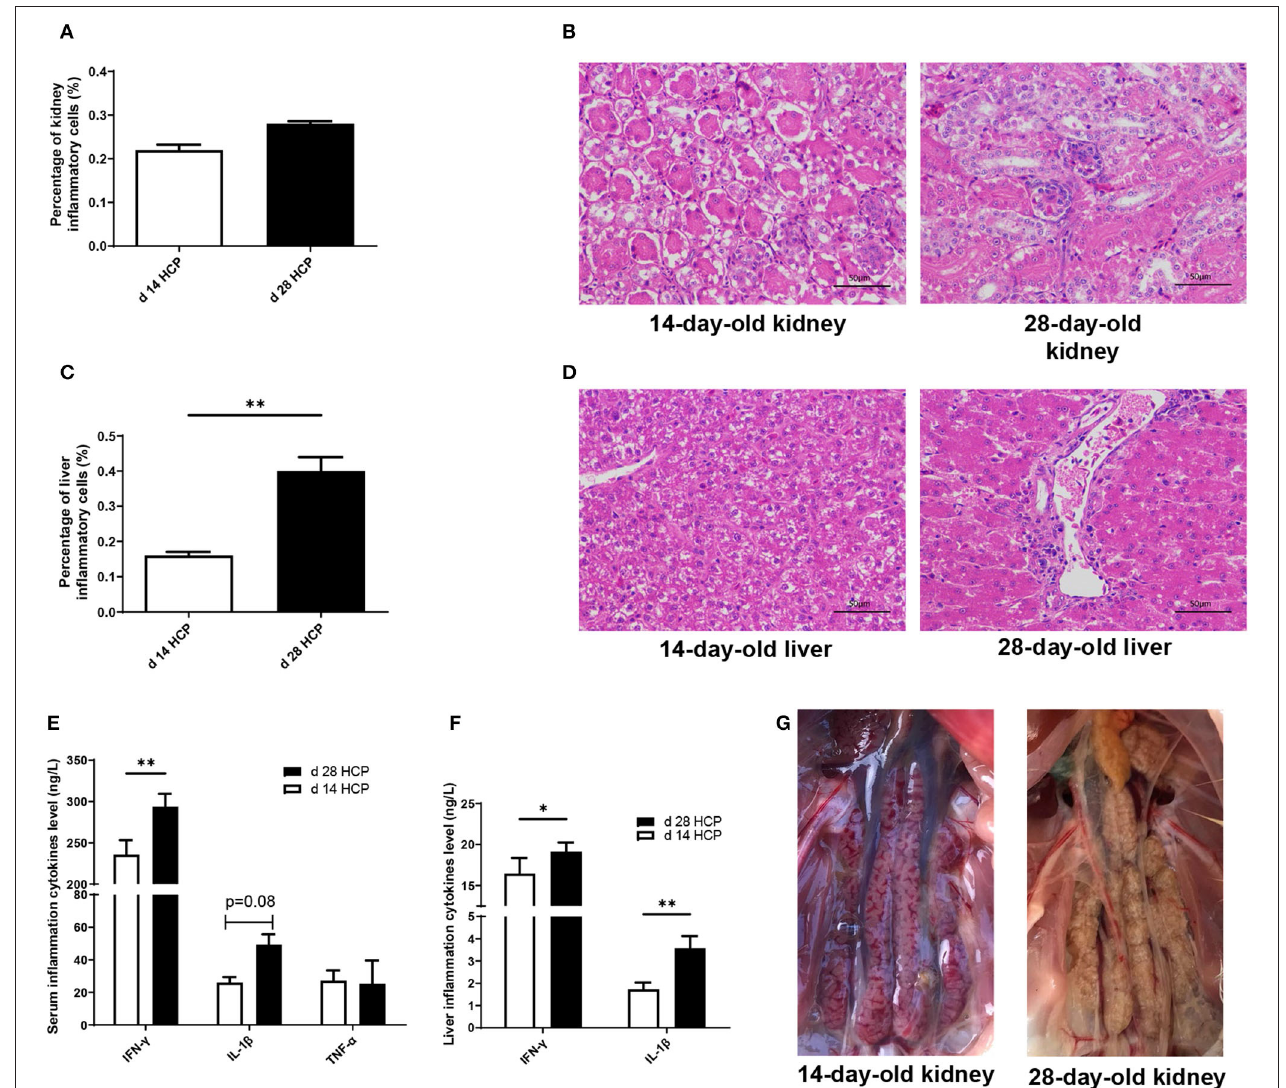
FIGURE 1 | A high-calcium and high-protein (HCP) meal-based diet causes an inflammatory response in geese. (A) Percentage of inflammatory cells in the kidney. (B) Kidney of day 14 and 28 HCP (bar = 50 µ m); the image was taken at magnification of × 400. (C) Percentage of inflammatory cells in the liver. (D) Liver of day 14 and 28 HCP (bar = 50 µ m); the image was taken at magnification of × 400. (E) Serum inflammation cytokine level. (F) Liver inflammation cytokine level. (G) Clinical signs of kidney appearance in the development of gout (bar = 1cm). Error bars represent the standard error of the mean ( n = 6/group). *Mean significant difference ( p < 0.05). **Mean extremely significant difference ( p <